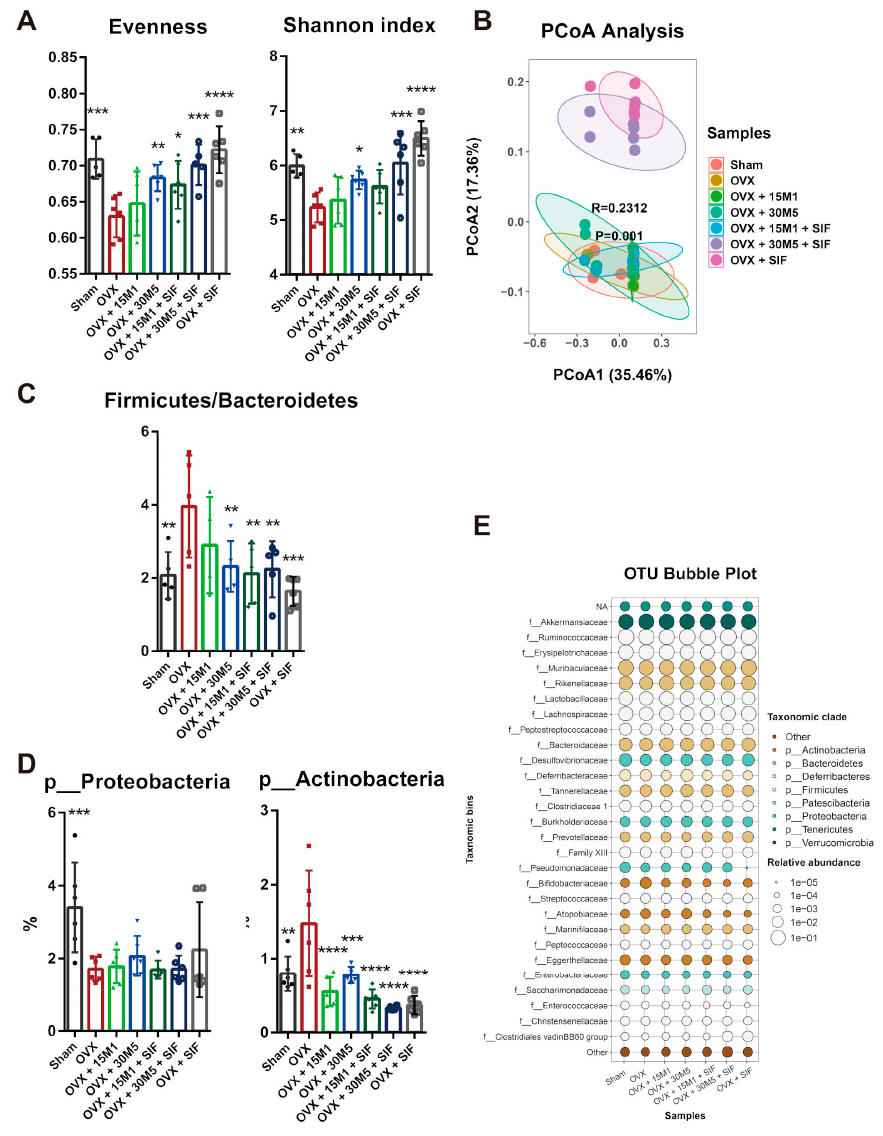
Figure 5. Diversity of intestinal microbiota reduced in ovariectomy and changed by a SIF diet treatment. ( A ) Alpha diversity in fecal samples. ( B ) Beta diversity in fecal samples was measured using principal coordinate analysis (PCoA) of unweighted UniFrac. ( C )The radio of Firmicutes and Bacteroidetes. ( D ) The changed abundance at phylum level. ( E ) Differential abundance at family level between groups was shown with an OTU bubble plot. * p < 0.05, ** p < 0.01, *** p < 0.001, **** p <0.0001 compared with the OVX group. Data present as the means ± SD. Significant difference between study groups were evaluated using ordinary one-way analysis of variance (ANOVA) and uncorrected Fisher’s LSD multiple comparison